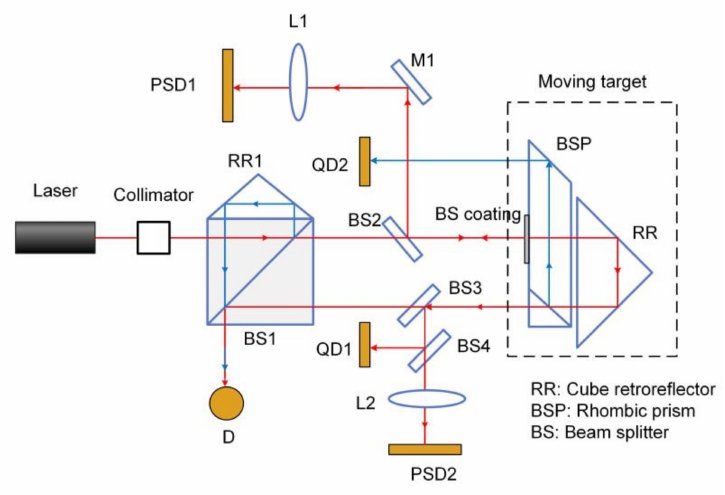
Figure 10. Schematic of the 6-DOF measurement system based on laser collimation